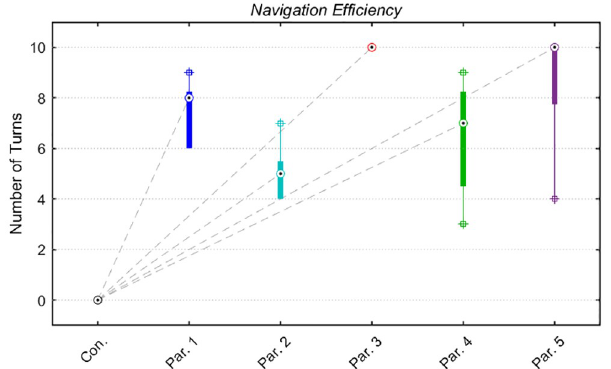
Fig 8. Individual distributions. The boxplot highlights individual distributions needed to advance through all ten turns in the experimental condition. The circles represent the median values for each individual. The bottom edge of the box represents the 25 th percentile and the top edge represents the 75 th percentile. Lines extending from the box connect to the most extreme values that are not outliers and are represented by crosses. The gray dashed line represents the disparities in median between the control and experimental condition for each